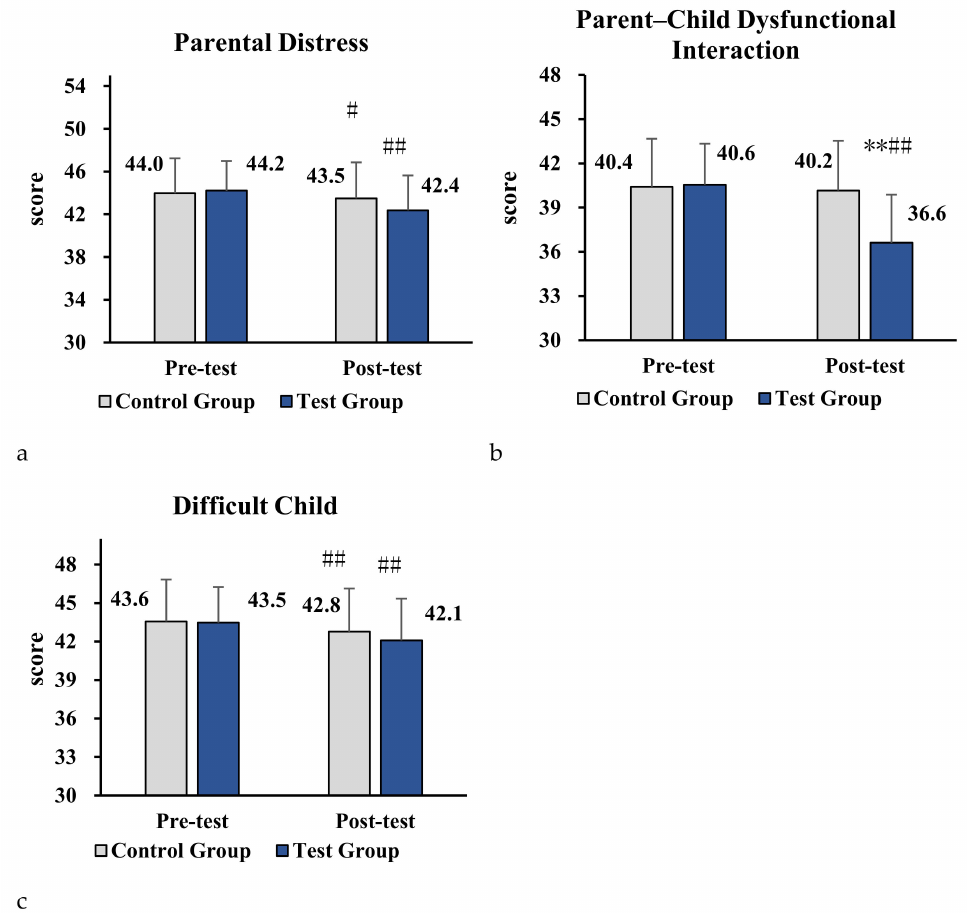
Figure 3. ( a–c ) Impact of parent–child physical activity program on sub-scales of parental distress, parent–child dysfunctional interaction, and child difficulty in the two groups. Note. Compared with the control group, * denotes p < 0.05, ** denotes p < 0.01. Compared with pre-test, # denotes p < 0.05, ## denotes p <